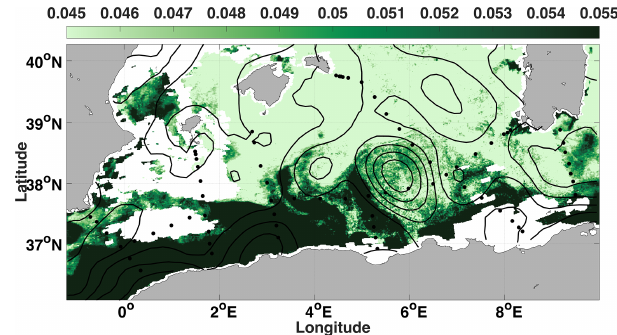
Figure 5. Level 3 Ocean Color image, expressed in concentration of chlorophyll- a (mgm − 3 ), on 25 August 2014. The black contours represent ADT (absolute dynamic topography) on the same date. Data from CMEMS (Copernicus Marine Environment Monitoring